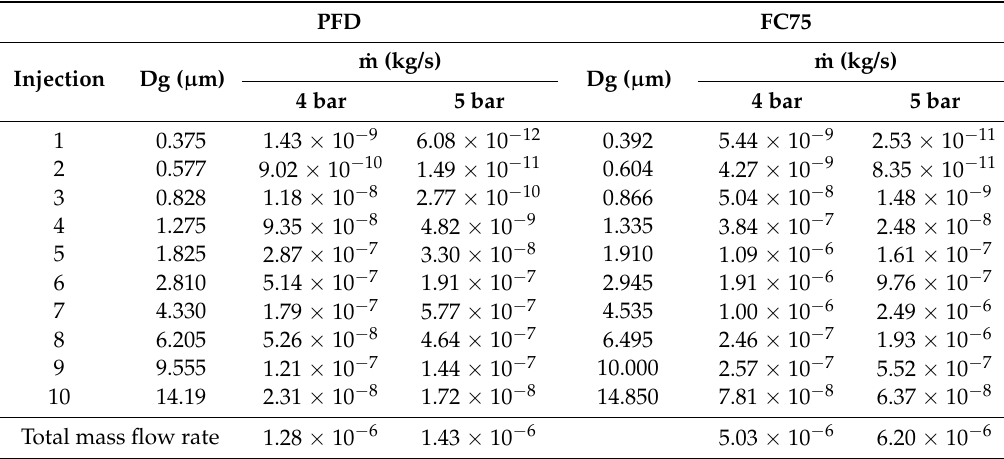
Figure 5. Computational domain and boundary conditions. Table 5. Particle initial conditions for the PFD (left) and FC75 (right) compounds obtained from experimental measurements. PFD